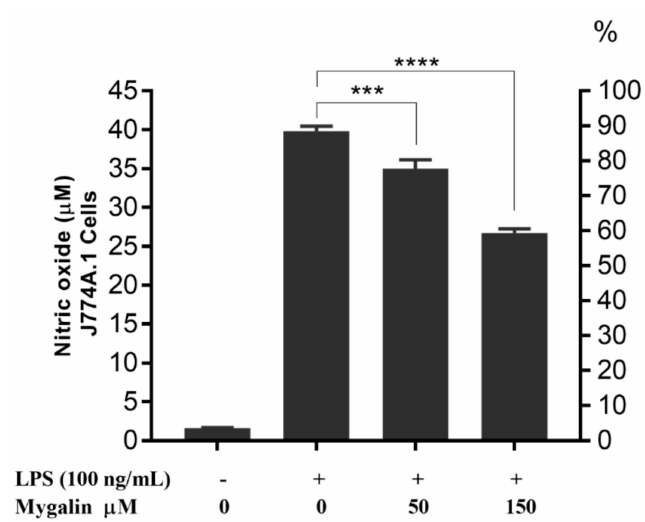
Figure 6. E ff ect of mygalin on the production of NO induced by LPS in J774A.1 cell. Cells were pretreated for 1 h with mygalin (50 and 150 µ M), and then washed with medium and new media plus LPS (100 ng / mL) were added. After 24 h NO was measured in the culture supernatant The bars represent the mean ± SEM of three independent experiments. (*** p < 0.001, **** p < 0.0001).